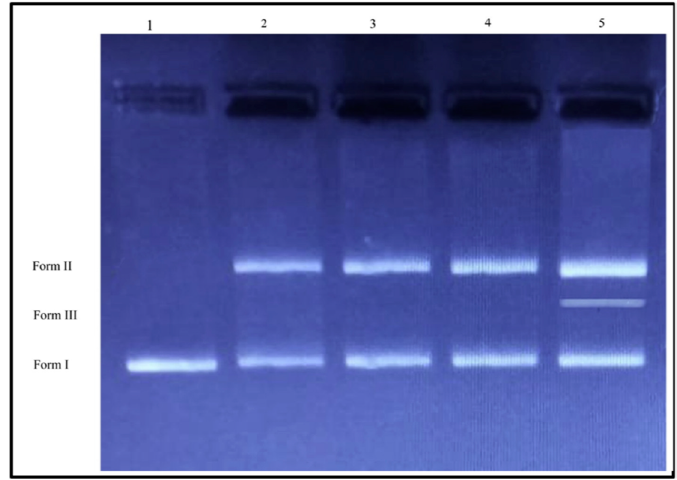
Figure 9. DNA cleavage activity of Rc-AgNPs. Lane 1, pBR 322 DNA; Lane 2, pBR 322 DNA + 100 mg/L of Rc-AgNPs (60 min incubation); Lane 3, pBR 322 DNA + 200 mg/L of Rc-AgNPs (90 min incubation); Lane 4, pBR 322 DNA + 100 mg/L of Rc-AgNPs (60 min incubation) and Lane 5, pBR 322 DNA + 200 mg/L of Rc-AgNPs (90 min incubation) Rc = Rosa canin , adapted with permission from